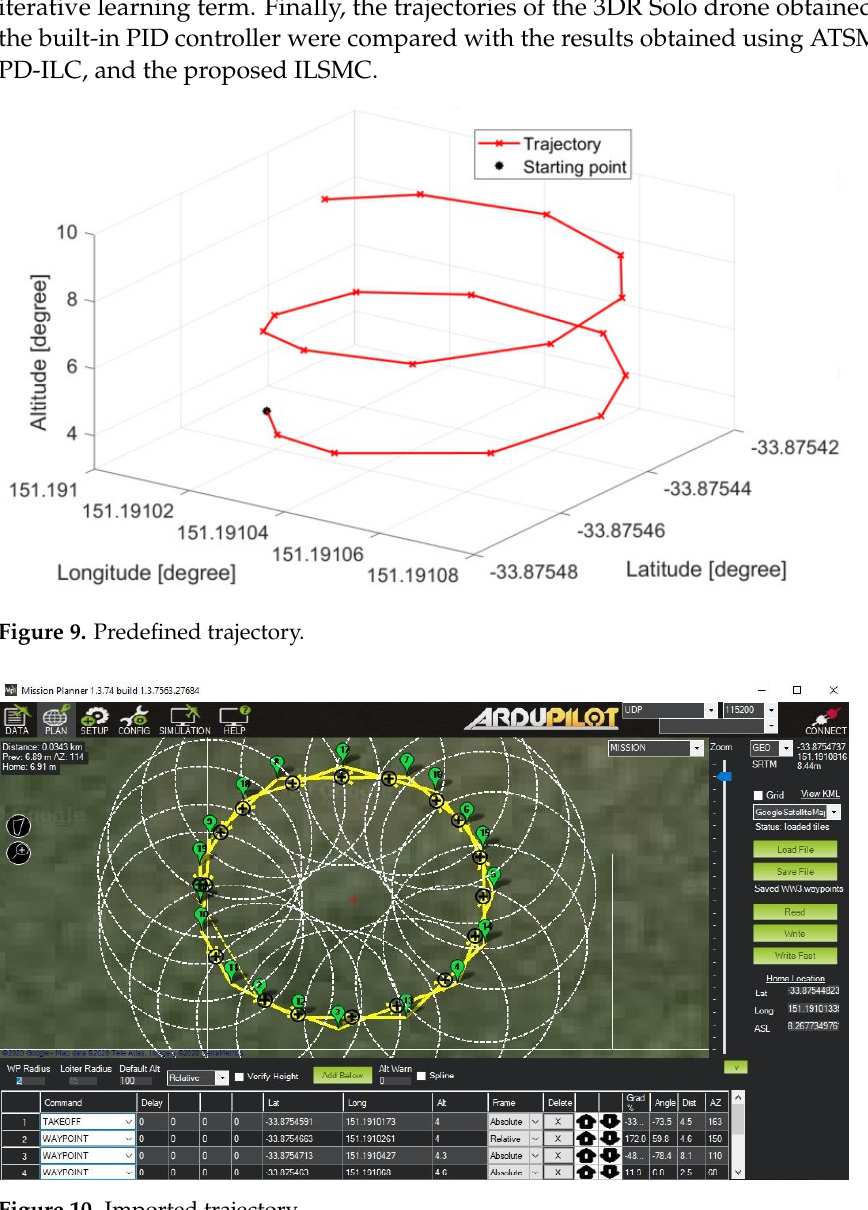
Figure 10. Imported